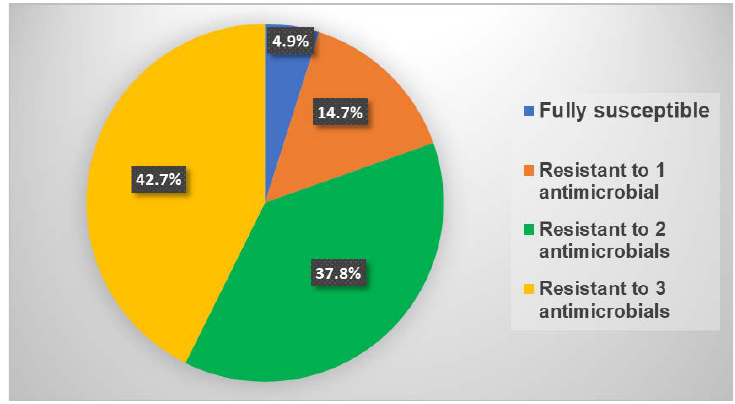
Figure 2. Distribution of NG isolates with resistance or intermediate resistance to multiple antimicrobials.